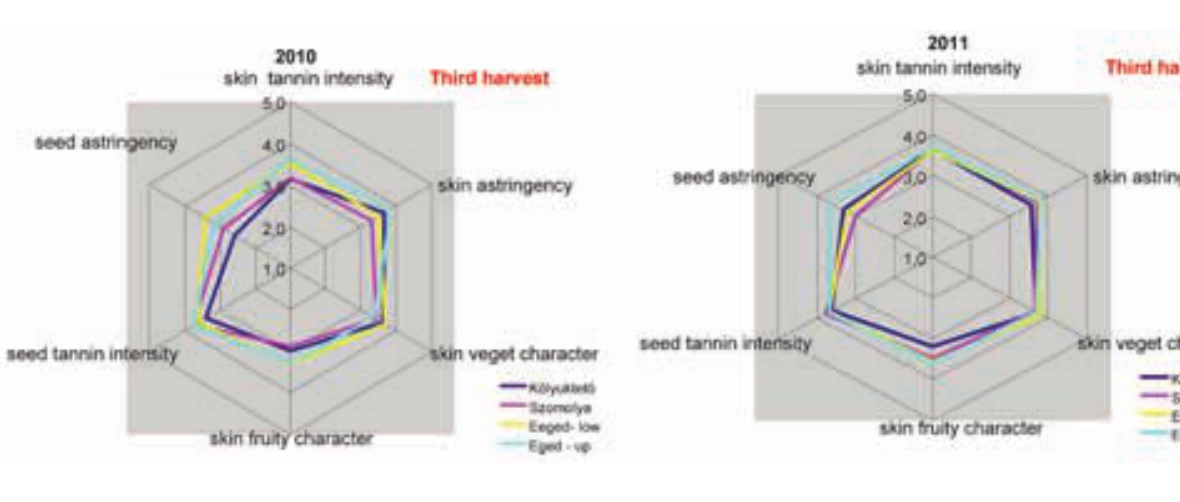
Figure 1 c: Main sensorial characters of the berry skin and the seeds (2010-2011- Third harvest